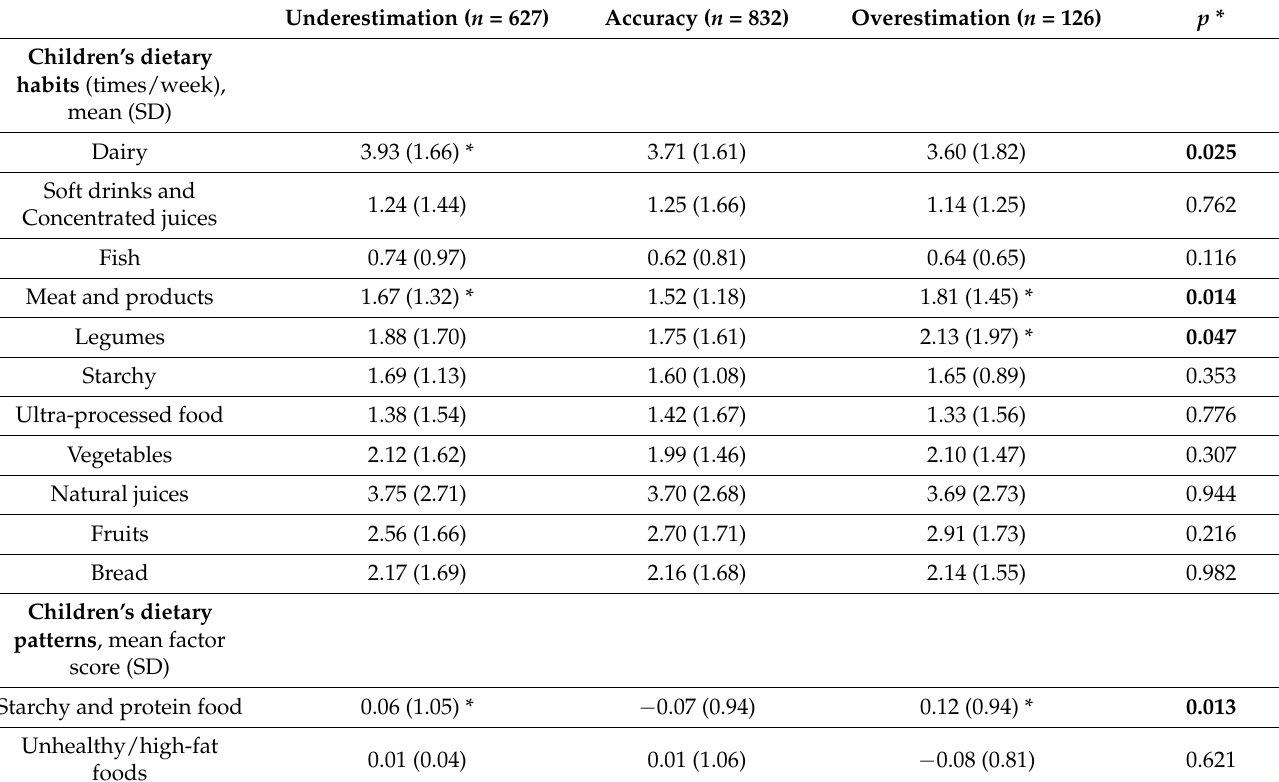
Table 3. Children’s dietary habits and patterns, by self-perceived agreement with actual weight